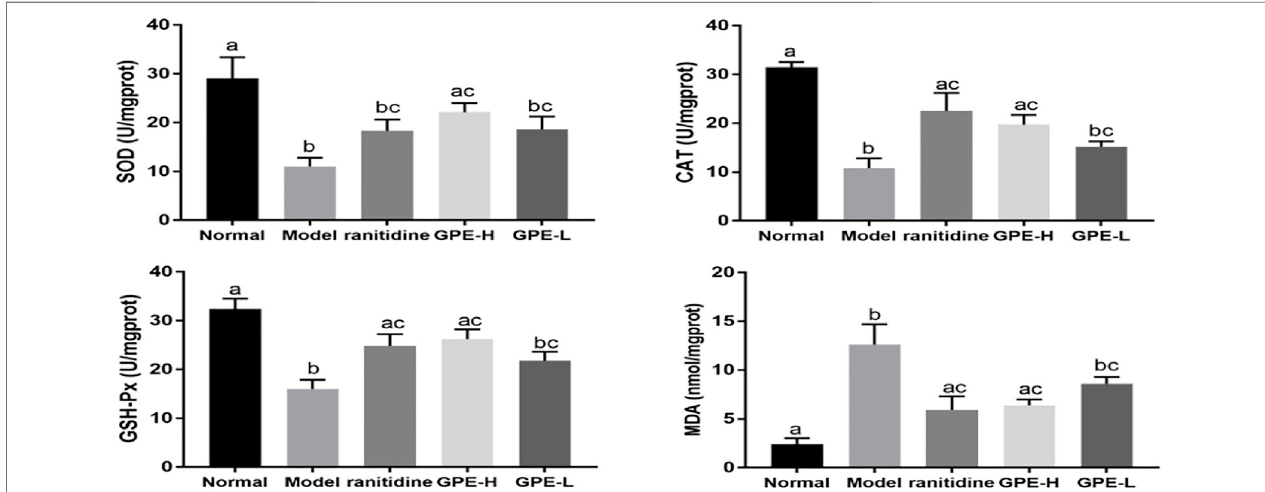
FIGURE 5 | Gastric tissue levels of SOD, CAT, GSH-Px and MDA in mice. The data are shown as mean ± SD (n (cid:2) 8). a – c Mean values with different letters are signi fi cant difference ( p < 0.05) according to analysis of variance.